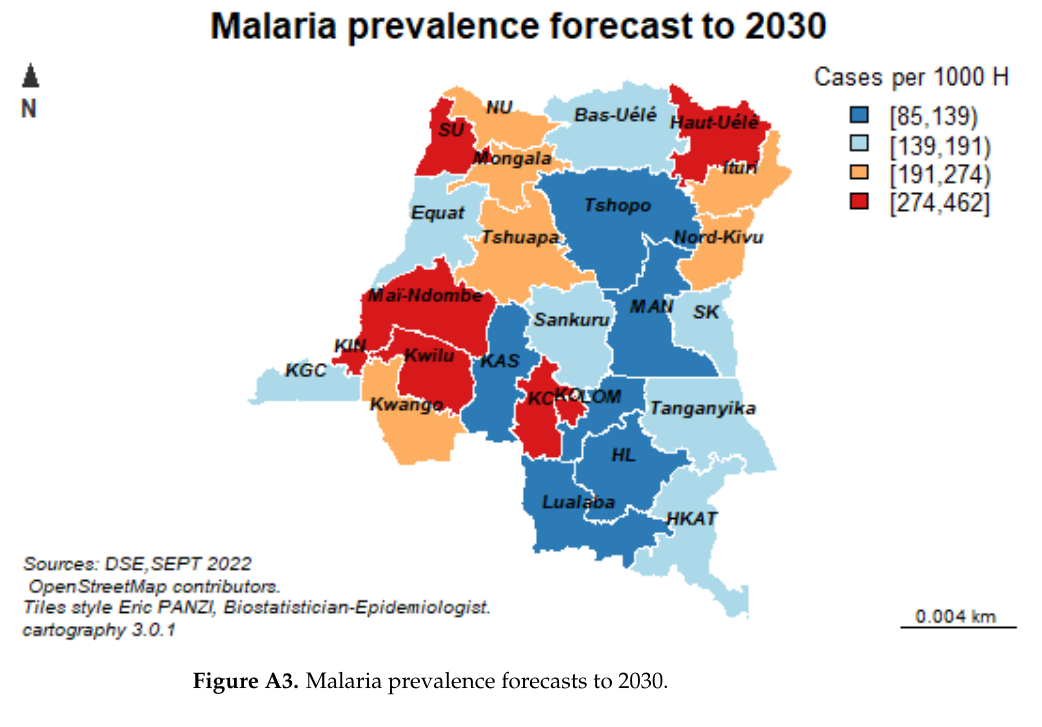
Figure A2. Malaria prevalence forecasts to 2025.